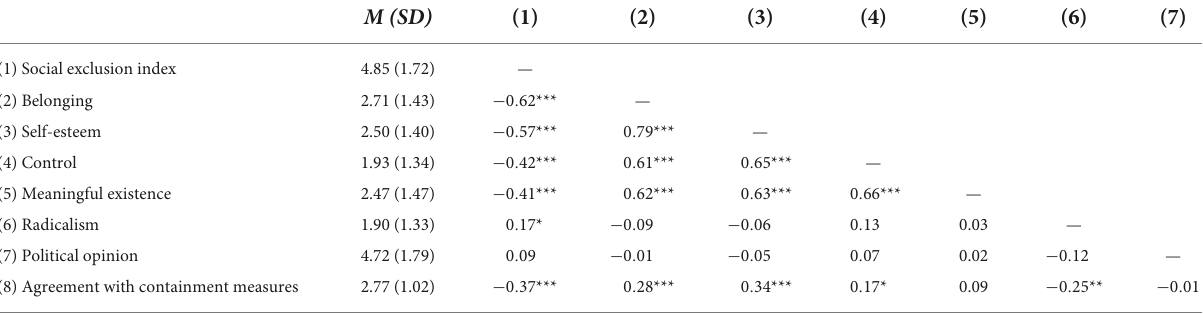
TABLE 2 Means (and standard deviations) of as well as intercorrelations between analyzed variables.